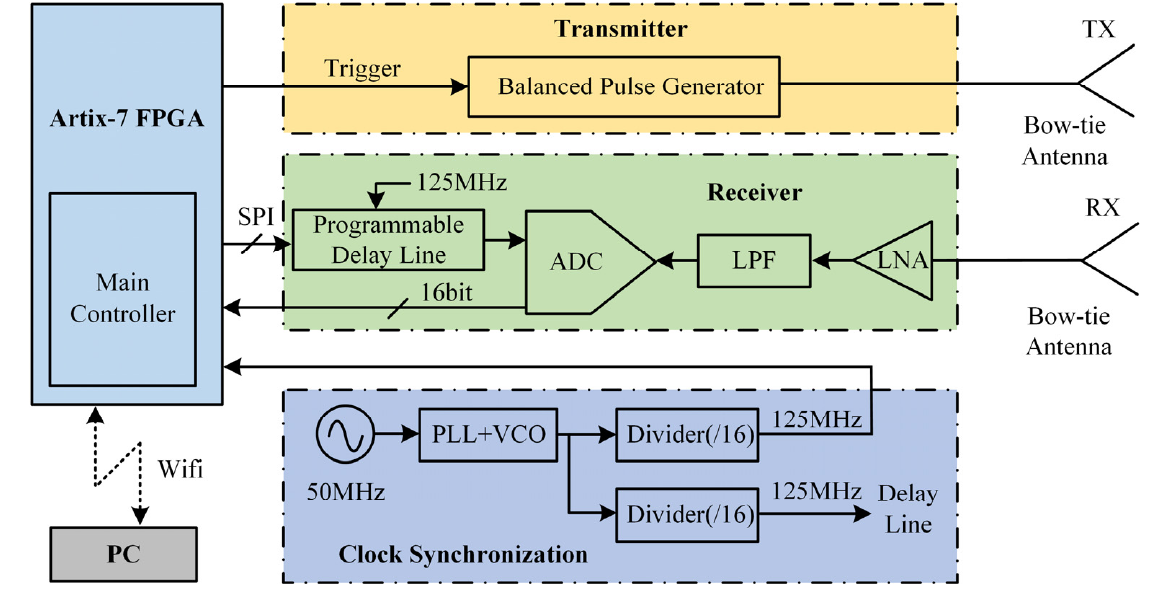
Figure 7. The blocks of the used UWB impulse radar. Table 2. Parameters of the radar.